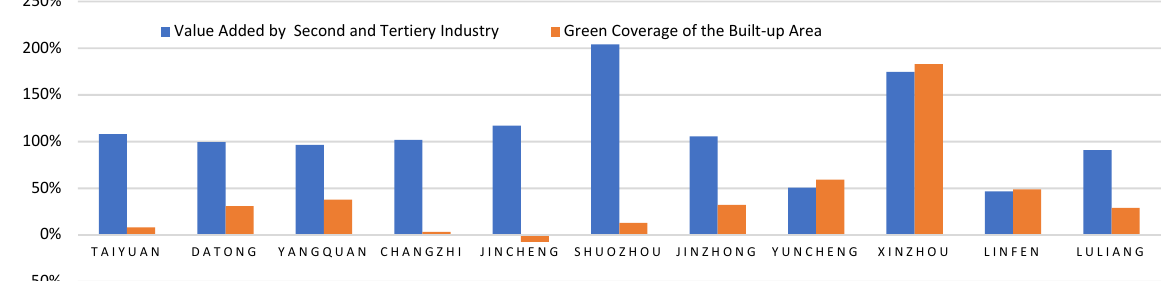
Figure 2. The percentage increase of output variables, such as the value added by the secondary and tertiary industries and green coverage of built-up areas, between 2006 and 2015.